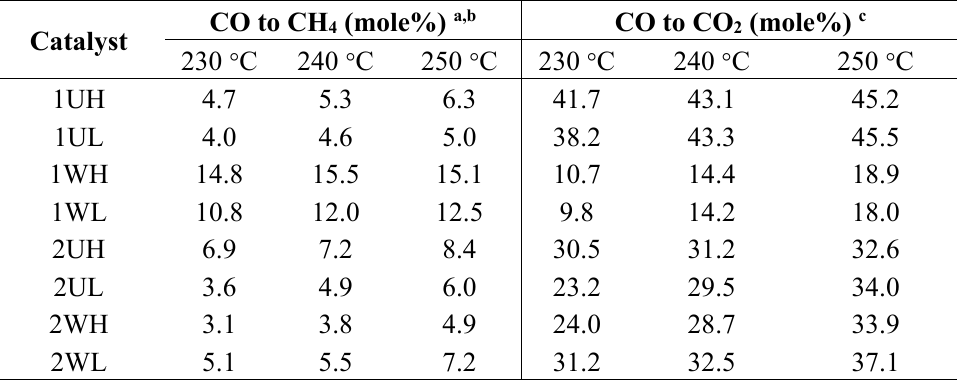
Table 3. Selectivity of catalysts at different temperatures.